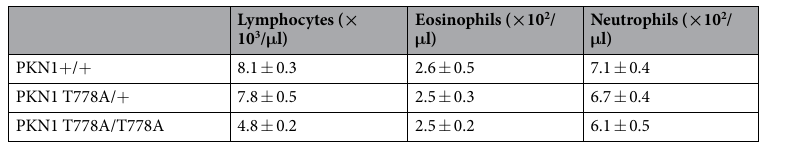
Table 1. White blood cell cellularity in the peripheral blood (absolute number) (mean ±